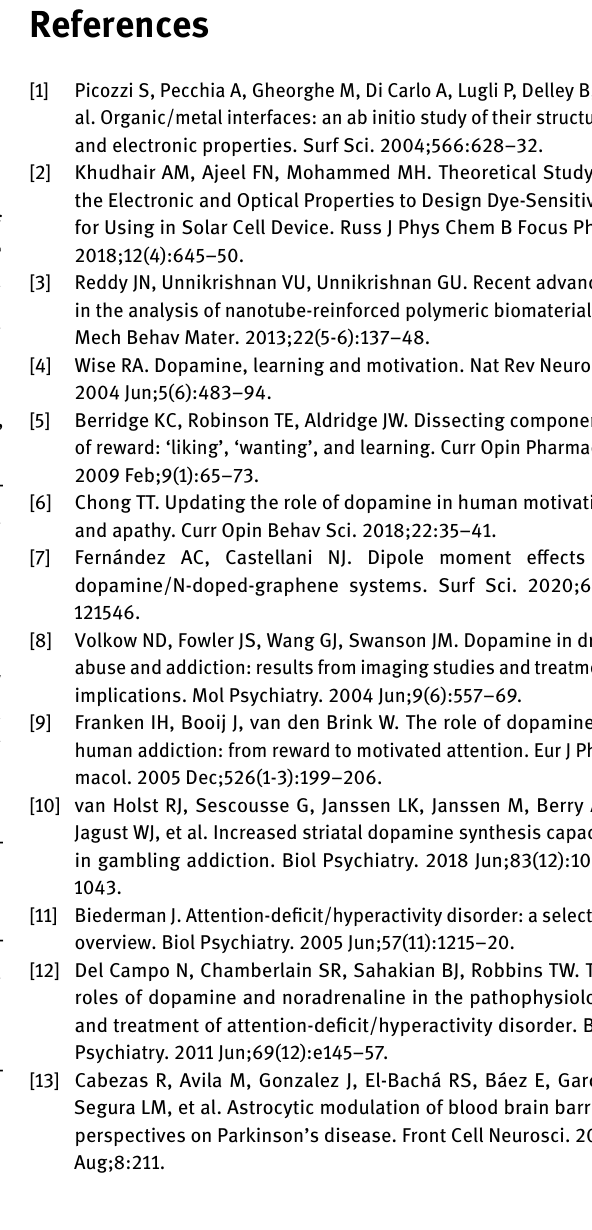
good agreement with references to the oscillator strengths ranging at (0 and 1)